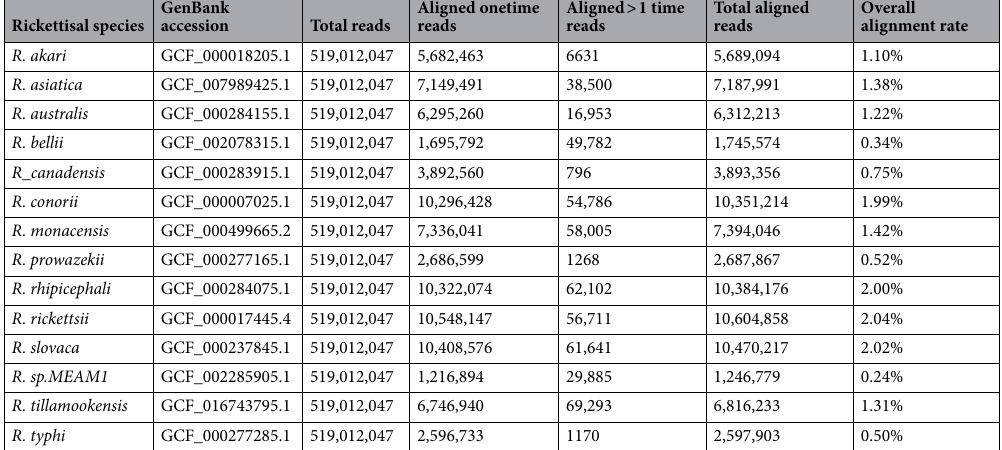
Table 1. Aligned reads to complete rickettisal genomes.